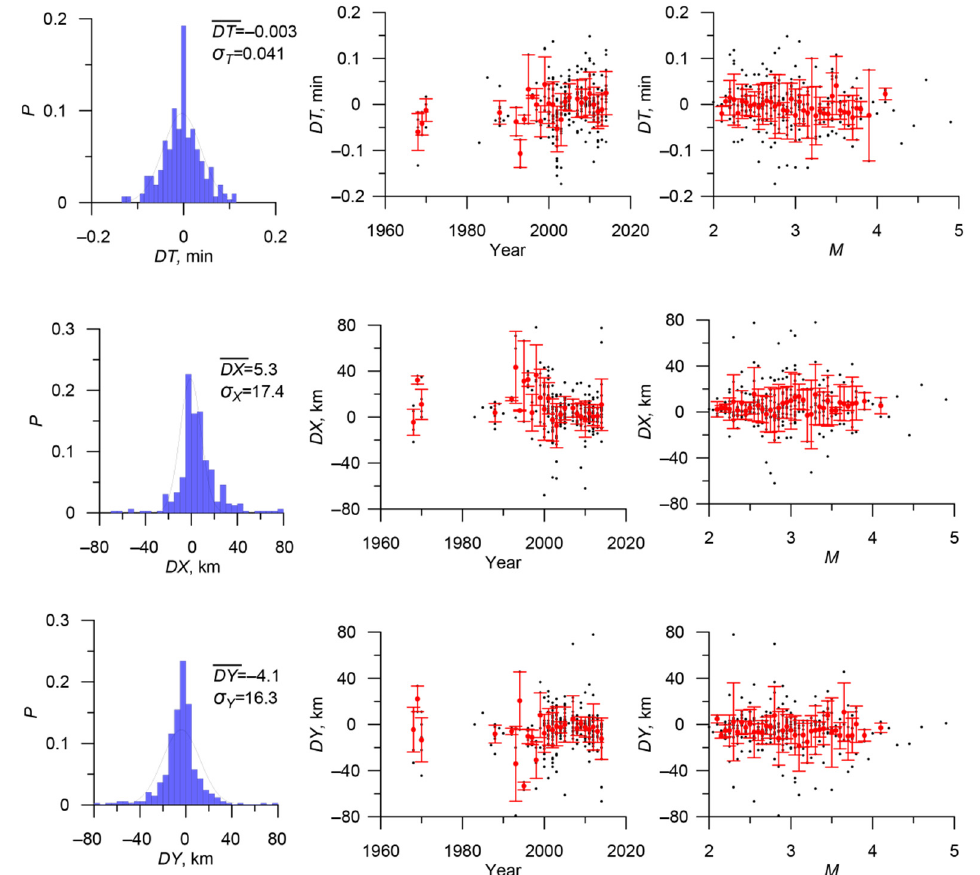
Figure 3. Distributions of DT , DX , and DY for the nearest events from the YAK and NER catalogs, and the dependence of the standard deviations σ T , σ X , and σ Y and the mean values DT , DX , and DY on the time and magnitude of the events. The red dots and bars are the population mean values and standard deviations, respectively.